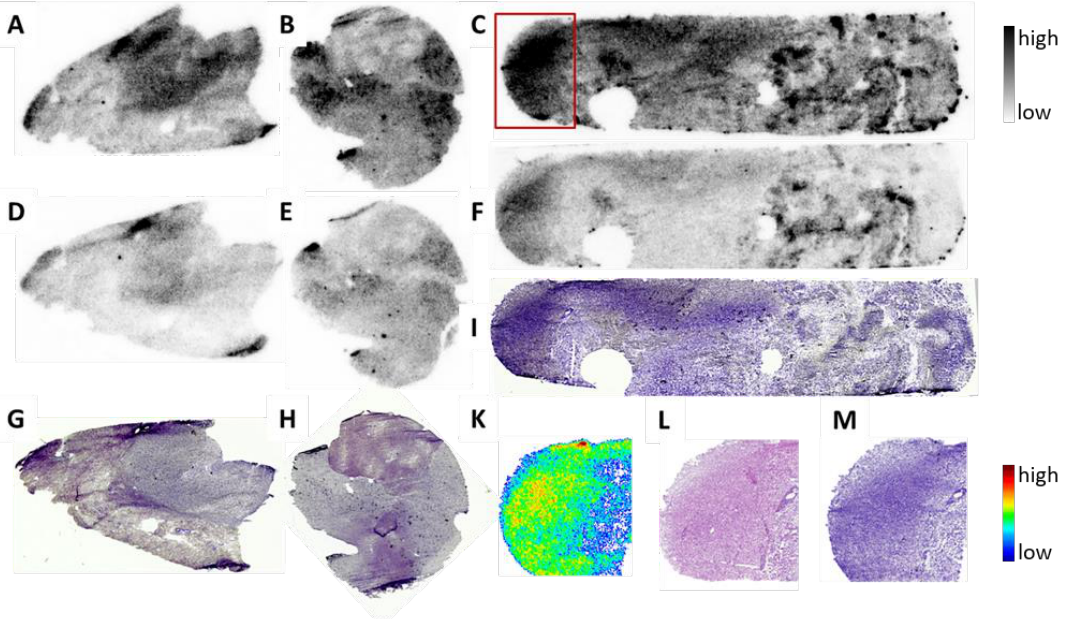
Figure 6. Sig1R autoradiography with the sig1R-specific PET ligand ( S )- (−) -[ 18 F]fluspidine in human GBM in vitro. Binding of ( S )- (−) -[ 18 F]fluspidine at 4.5 nM in cryosections (12 µm) of tumour tissue obtained from three patients ( A , B , C ) demonstrated heterogeneous distribution throughout the slices. By co-incubation with 1 µM haloperidol ( D, E, F ), a substantial reduction in activity accumulation was obtained. Histochemical analysis of corresponding sections was performed by Nissl staining ( G , H , I ). Analysis of one sample at higher magnification (red square in C ) demonstrated correlation of the activity accumulation ( K ) with highly cell dense regions (H&E staining: L ; Nissl staining: M ). Length of the biopsies samples ~ 1 cm.